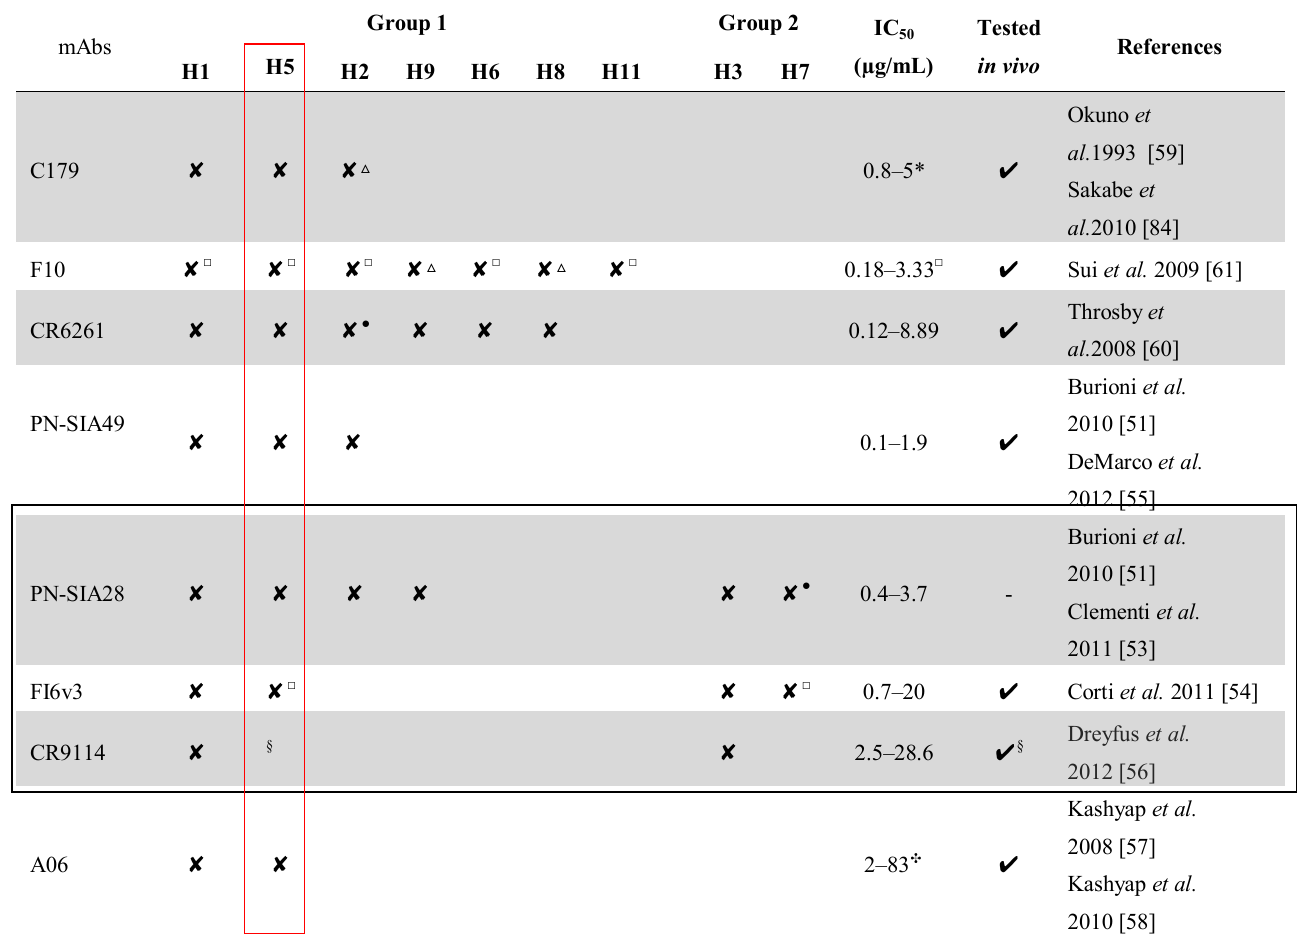
Table 1. Panel of mAbs endowed with heterosubtypic neutralizing activity. “ ✘ ” indicates the neutralization activity assessed against the isolates belonging to the different subtypes. The IC (half maximal (50%) inhibitory concentration) indicates the concentration of mAb 50 required for 50% inhibition in vitro . mAbs able to recognize highly divergent influenza subtypes are highlighted by black box. Red box indicates that all the mAbs are able to recognize epitopes on H5N1